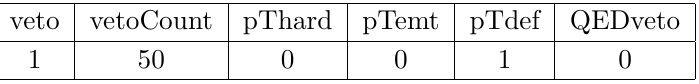
Table 2 . List of POWHEGHooks options.